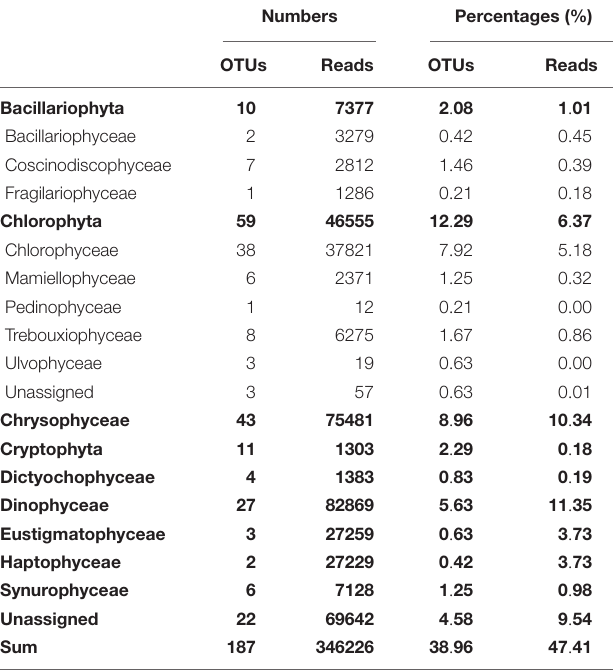
Frontiers in Microbiology |